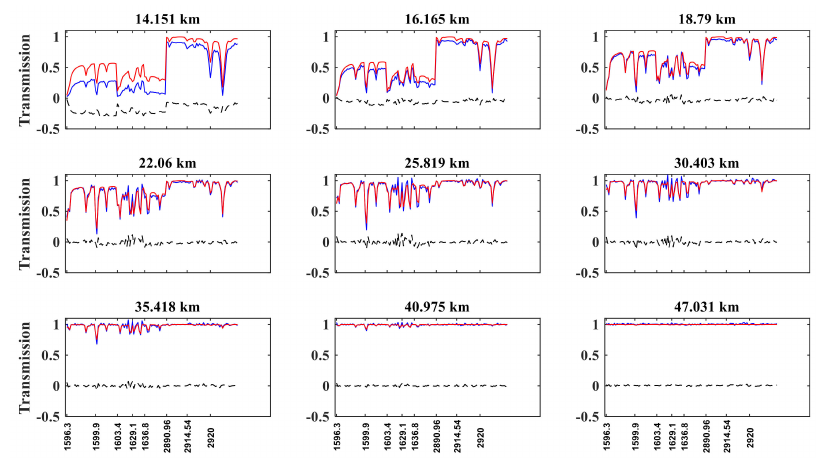
Figure 4. The same as Figure 3 but for NO 2 .